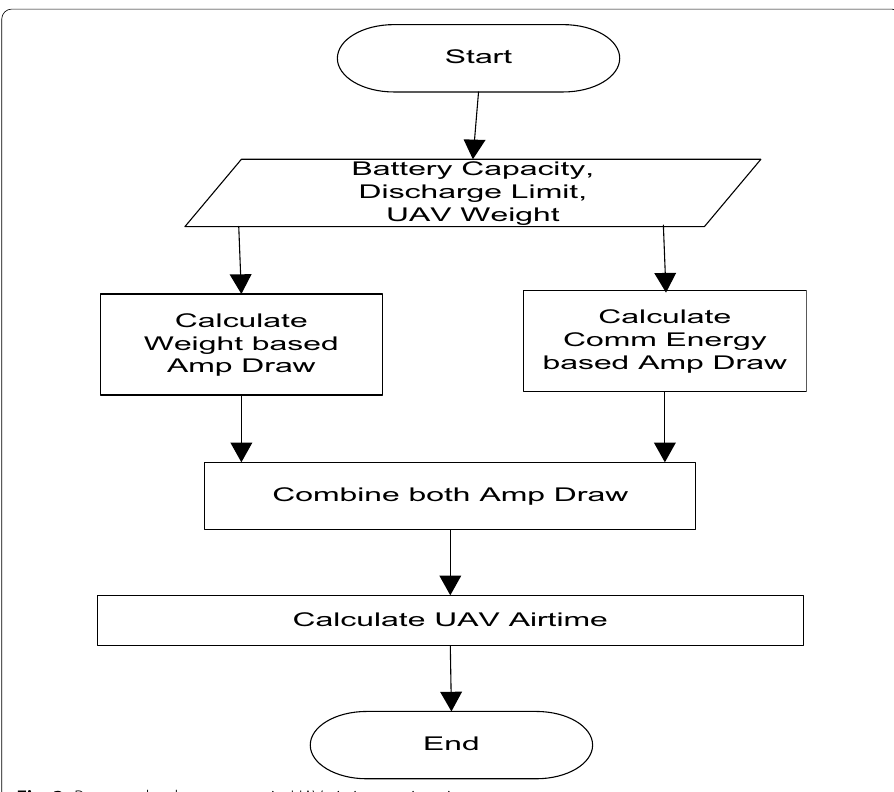
Fig. 3 Proposed enhancement in UAV airtime